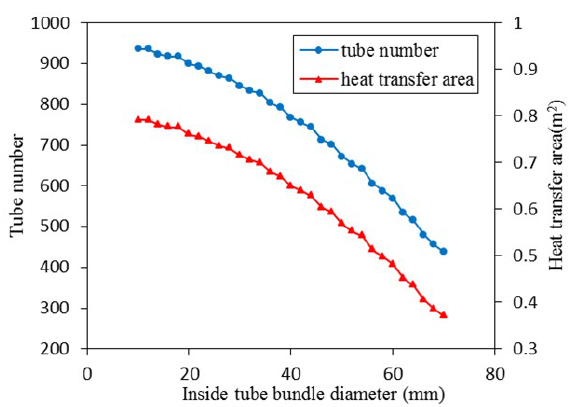
Figure 9. Tube number and heat transfer area separately versus inside tube bundle diameter.